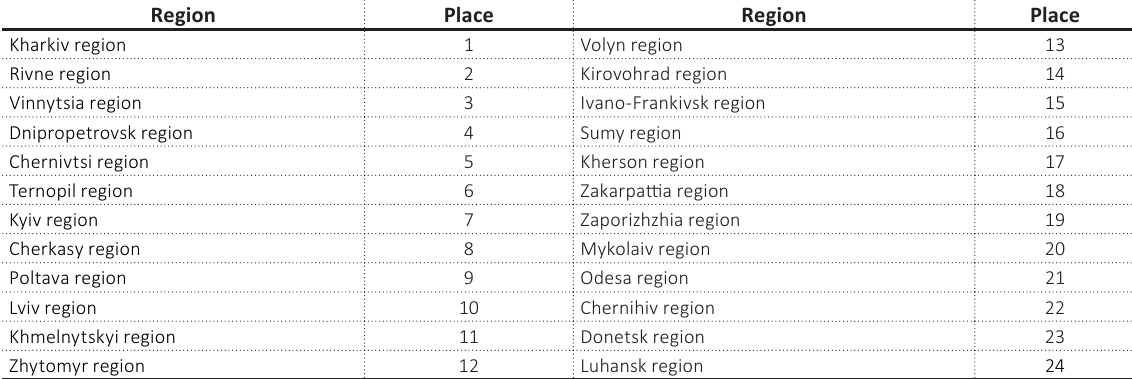
Table 1. Assessment of the socio-economic development of Ukrainian regions in 2018 Source: Ministry of Regional Development, Construction, Housing and Communal Services of Ukraine